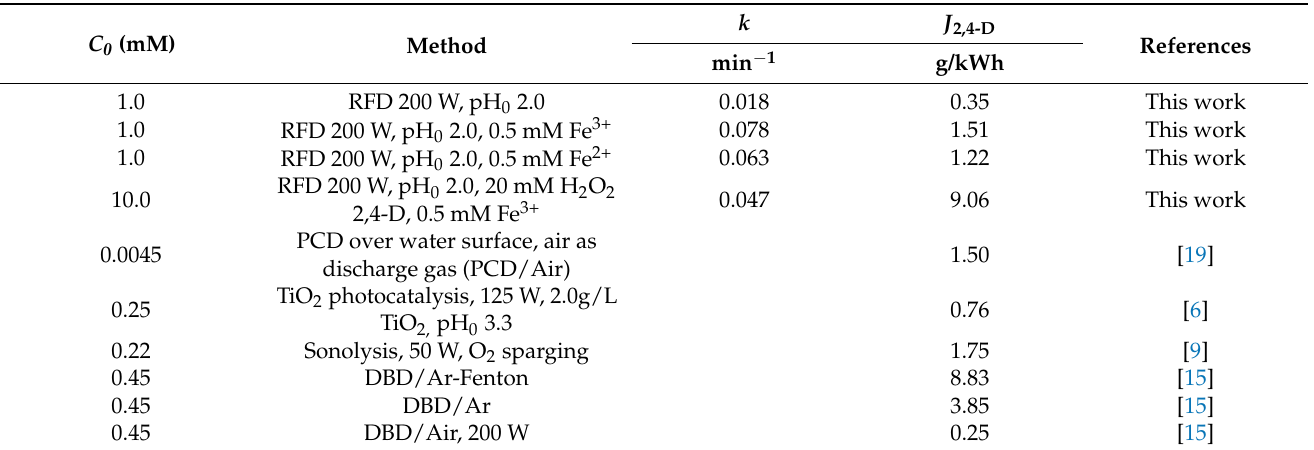
Table 1. Energy yields for 2,4-D removal of RFD and other